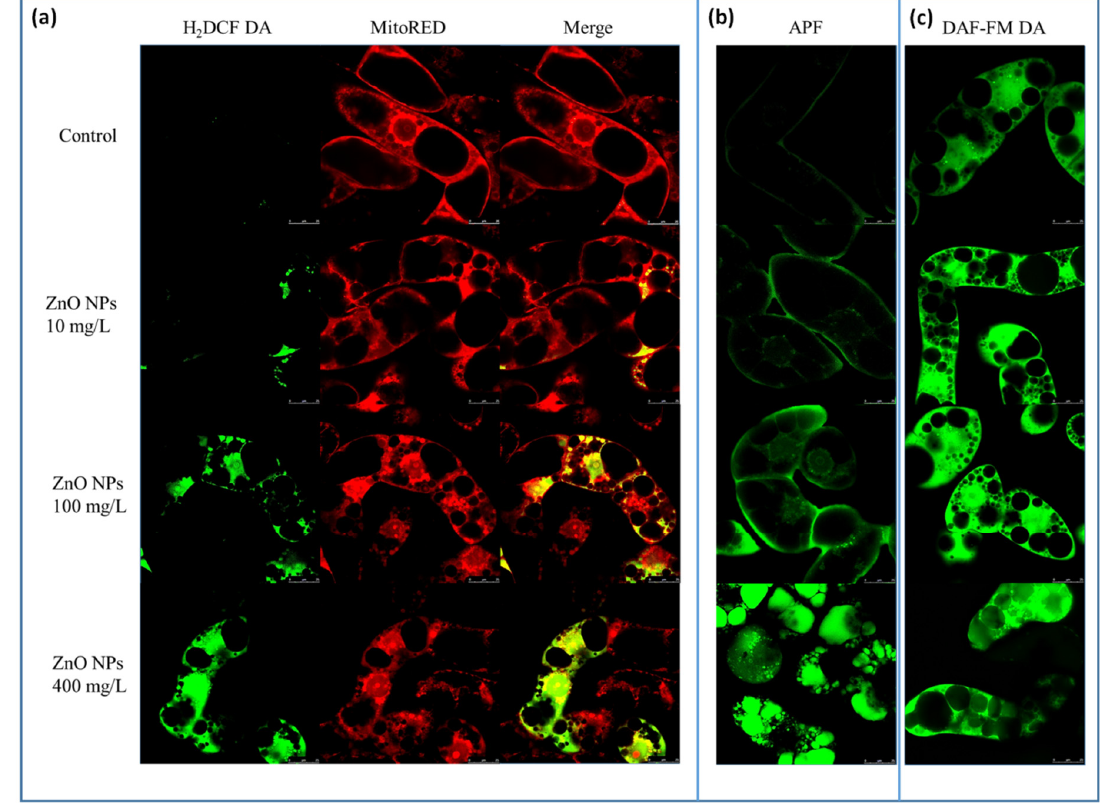
Figure 3. The effect of 0, 10, 100, and 400 mg/L ZnO NPs on BY-2 cells 72 h after the onset of the treatment. Visualization of ROS, mainly hydroxyl radicals, by 2´,7´-dichlorodihydrofluorescein (H2DCF DA), mitochondria according to its potential by MitoRED ( a ), hydroxyl radicals, peroxynitrite, and hypochlorite anions using 3 ′ -(p-aminophenyl) fluorescein (APF) ( b ); reactive nitrogen species visualized by 4-amino-5-methylamino-2 ′ ,7 ′ -difluorofluorescein diacetate DAF-FM DA ( c ). The length of bars represents 25 µm.